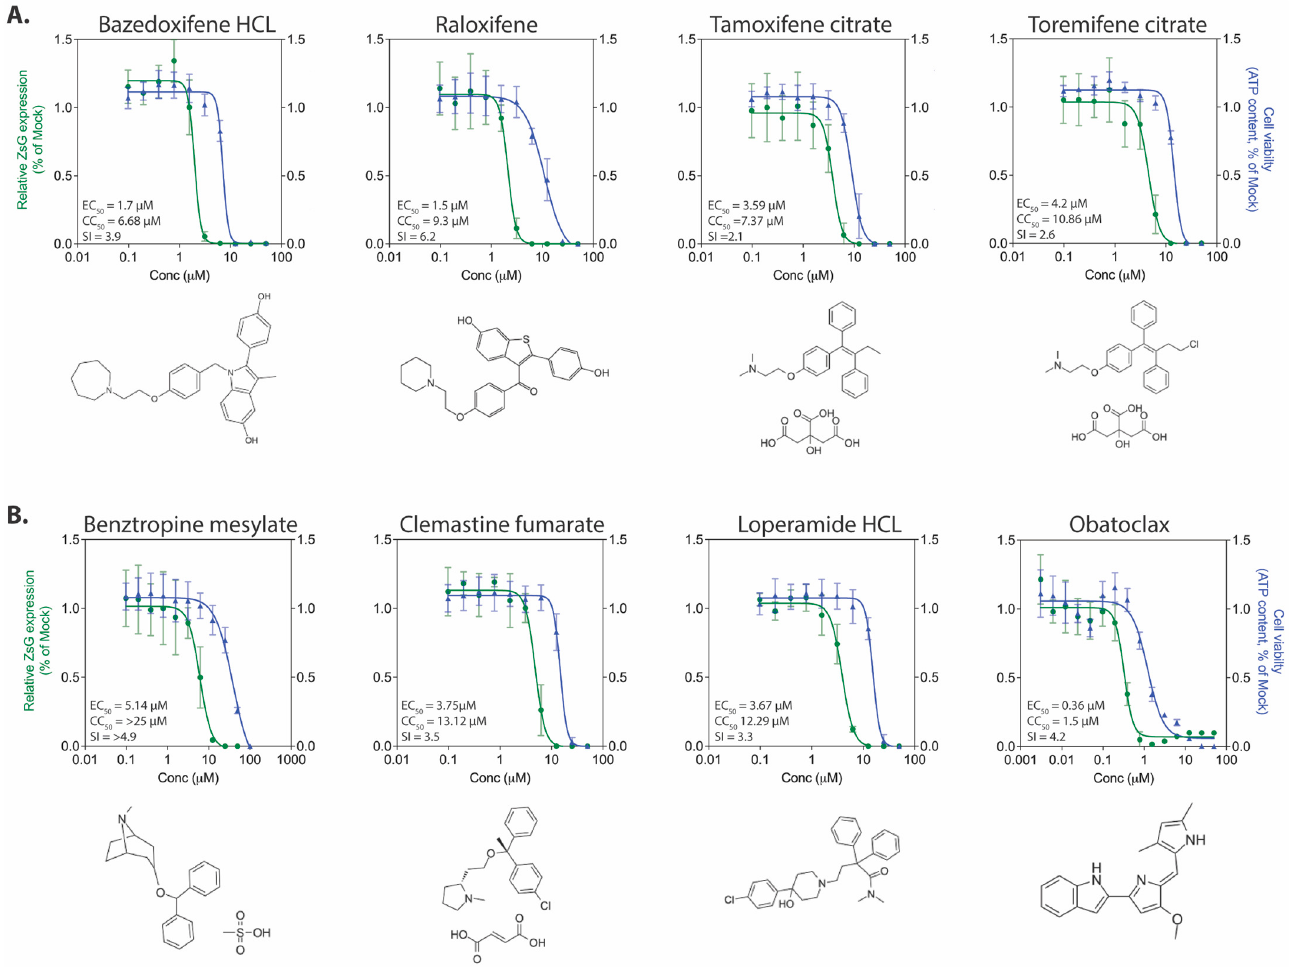
Figure 4. Antiviral activity of selective estrogen receptor modulators and additional compounds demonstrating antiviral effects. Concentration-response curves in Huh7 cells infected with rLUJV/ZsG (MOI 0.1) after being treated 1 h prior with: ( A ) selective estrogen receptor modulators (SERMs), or ( B ) protein kinase inhibitors. Relative ZsG expression is shown in green and cell viability is shown in blue. Values were normalized to mock-treated (DMSO only) infected cells. Each point represents the mean of quadruplicate wells, with error bars indicating standard deviation; graphs are representative of at least 3 independent experiments. Associated EC 50 , CC 50 , and SI values are provided, along with the chemical structure of each compound.